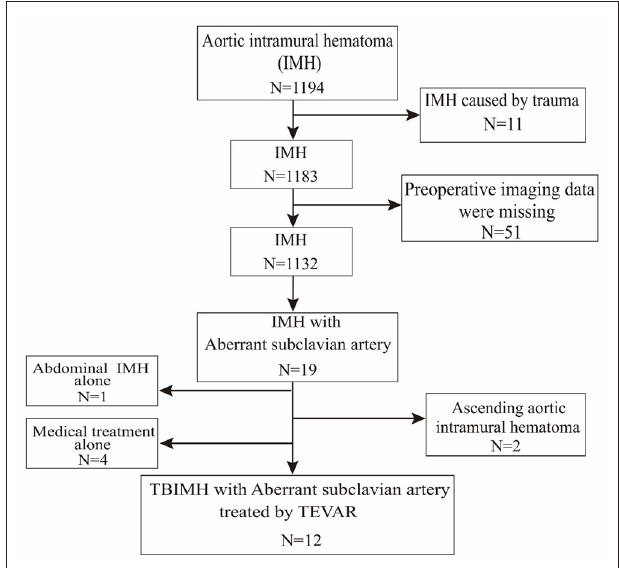
FIGURE 1 | Flowchart of patients screened from electronic medical records. TEVAR, thoracic endovascular aortic repair.